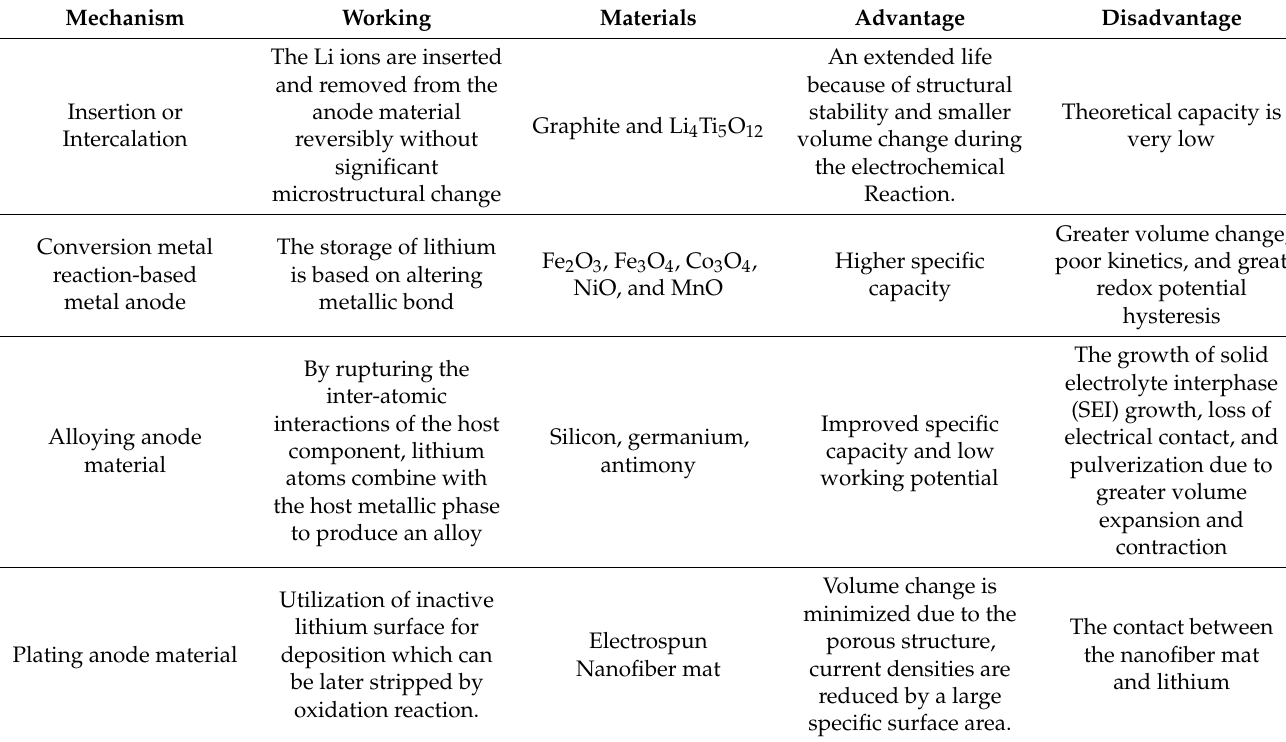
Table 2. Anode working